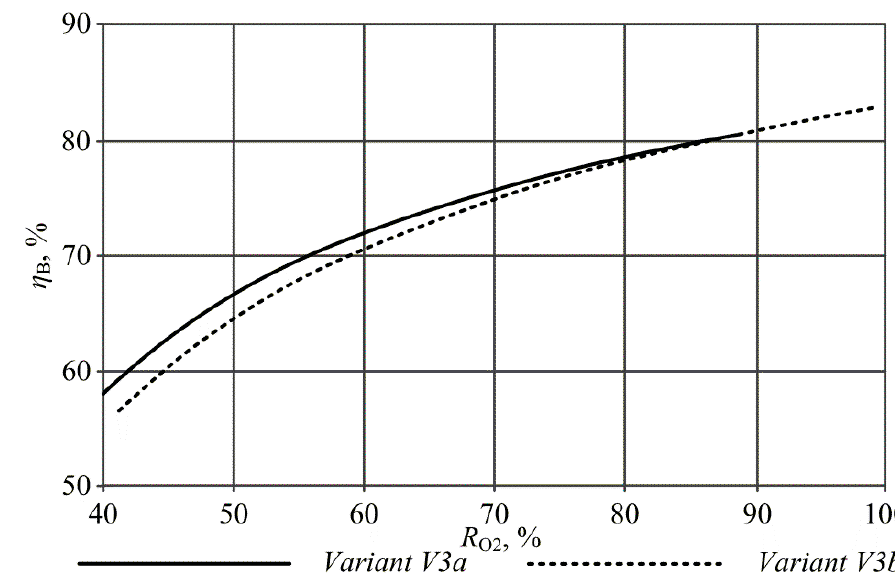
Figure 15. Thermal boiler efficiency as a function of the oxygen recovery rate.